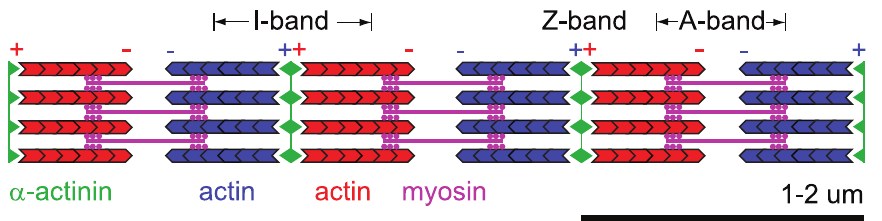
Figure 1. Schematic depiction of sarcomeric organization in myofibrils. Actin filaments (blue and red) are grafted at their plus-ends in an a - actinin rich crosslinking band, termed the Z-band (green). The repetitive units spanning from one Z-band to the next are referred to as sarcomeres and measure 1 { 2 m m in length. The myosin band (magenta) is traditionally called A-band, while the myosin-free part of the actin band is called I- band. Numerous auxiliary proteins ensure structural integrity and tune elastic properties.